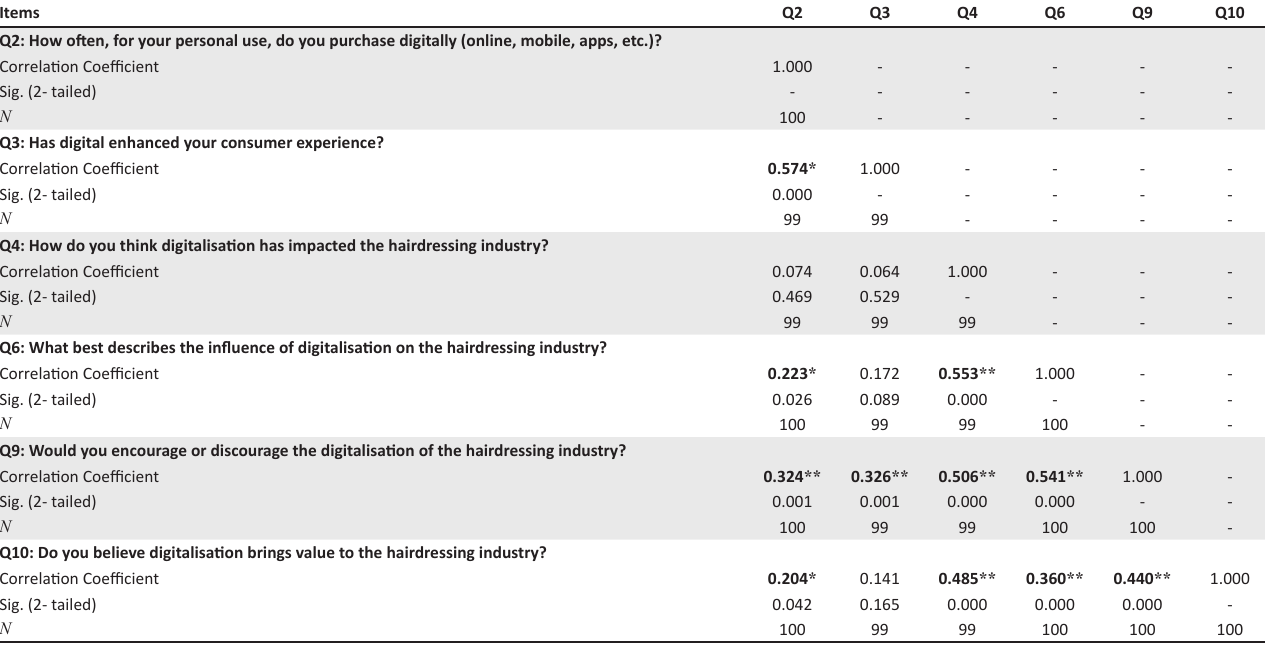
TABLE 6: Intercorrelations matrix (Spearman correlations) of the six variables. Items